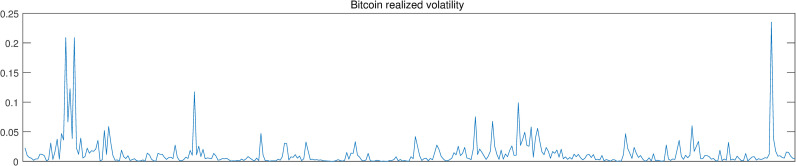
Realized volatility.